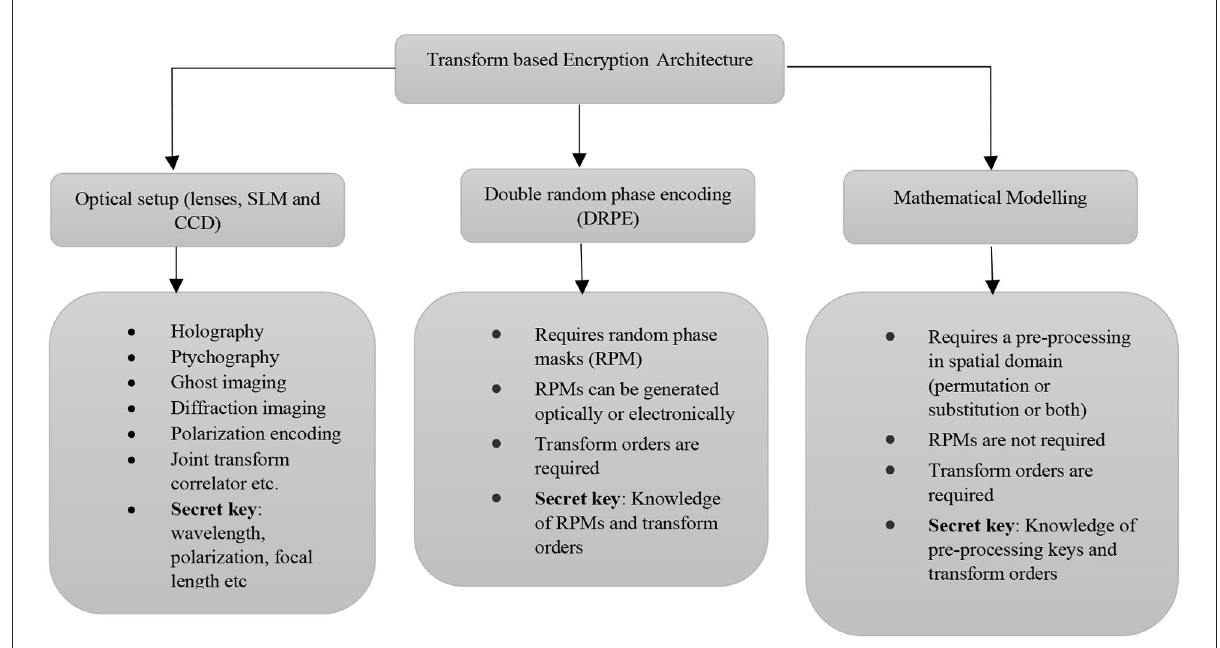
FIGURE1 Classification of architectures for fractional transform-based image